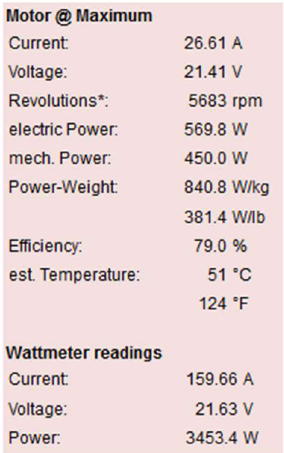
Table 3. Multistar Elite 5008-330 motor characteristics at full throttle using 18” 5.5” pitch propeller. Wattmeter readings are for all six motors